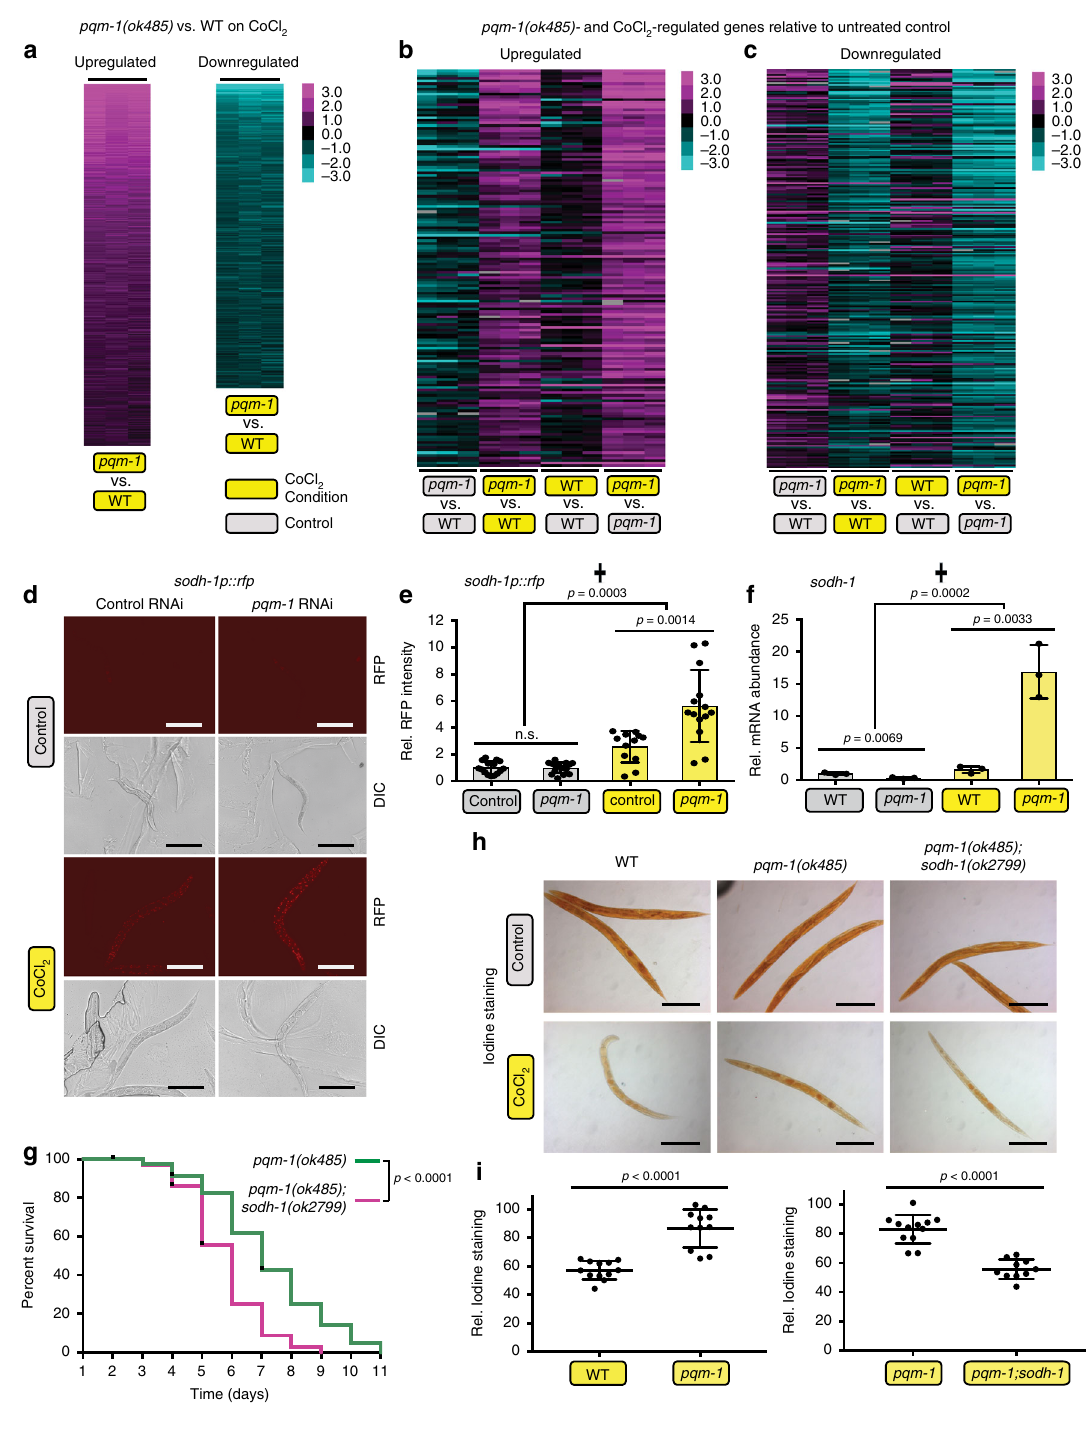
metabolism. pqm-1 and CoCl 2 -dependent upregulated gene categories are enriched for immune, defense, and stress responses, while downregulated genes are associated with the response to xenobiotic stimuli, oxidation-reduction processes, lipid metabo- lism, and transmembrane transport (Supplementary Fig. 2c, d and Supplementary Data 2). GO analysis of the pqm-1 and CoCl 2 -dependent upregulated gene sets, which were analyzed for expression changes relative to wild-type animals and untreated controls using two-class SAM, revealed an enrichment for oxidation-reduction processes and the innate immune